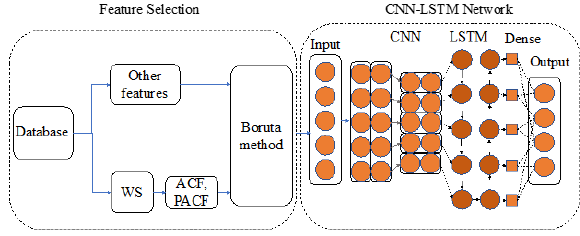
Fig. 2. The structure of FS- CNN–LSTM hybrid model.